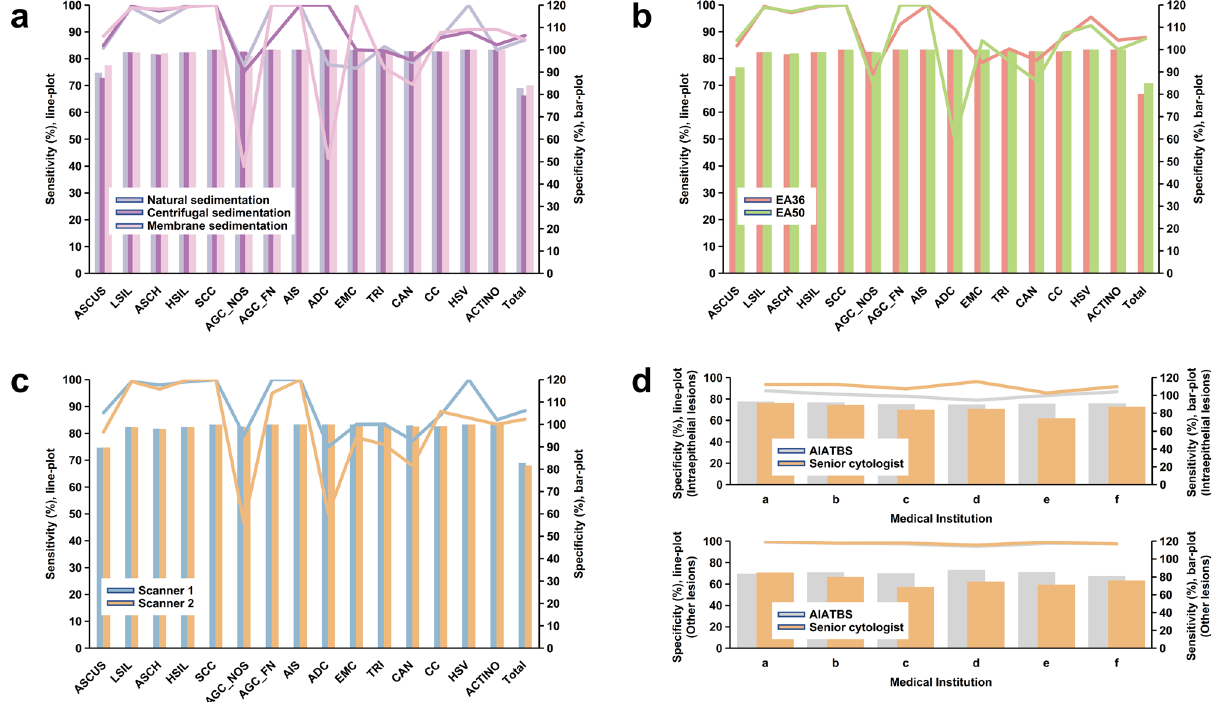
Fig. 6 AIATBS system achieved good generalization and showed higher sensitivity than senior cytologists. a The sensitivity and speci fi city of AIATBS system in predicting three different preparation smears. (Bar-plot: speci fi city; Line-plot: sensitivity). b The sensitivity and speci fi city of AIATBS system in predicting two different Papanicolaou stain smears. (Bar-plot: speci fi city; Line-plot: sensitivity). c The sensitivity and speci fi city of AIATBS system in predicting smears which digitized by two scanners. (Bar-plot: speci fi city; Line-plot: sensitivity). d Comparison of sensitivity and speci fi city between senior cytologist and AIATBS system in diagnosing cervical liquid-based thin-layer cell smears. (Bar-plot: sensitivity; Line-plot: speci fi